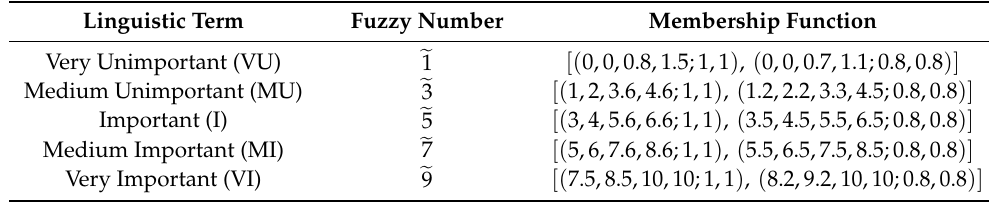
Figure 4. IT2 FSs of the linguistic words describing the indicator weights. Table 2. Words describing the indicator weights and their IT2 FSs.